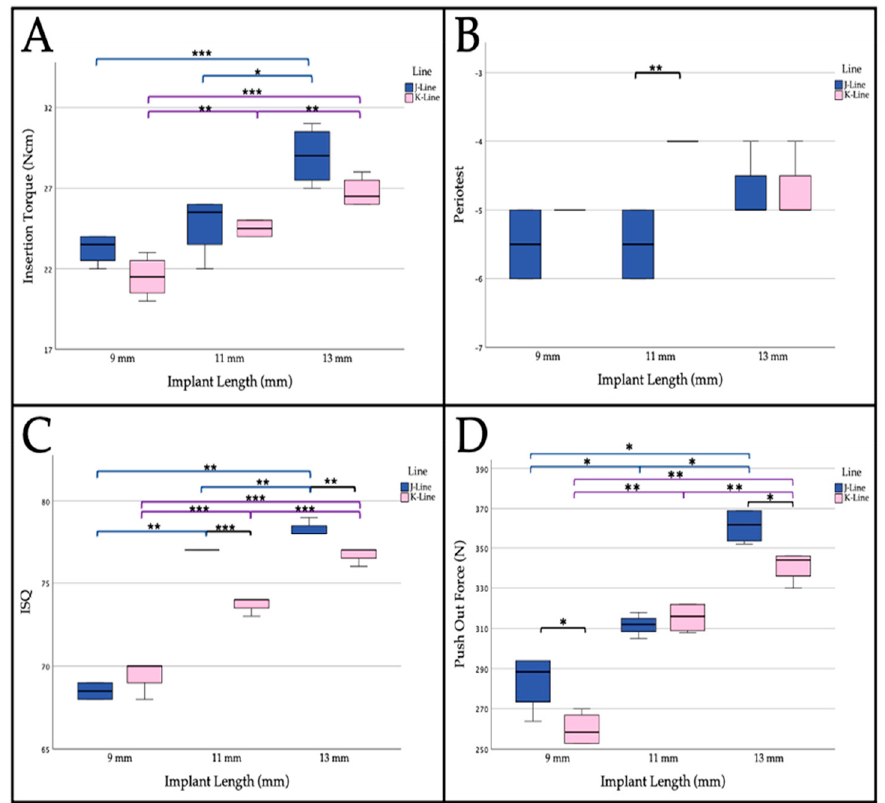
Figure 4. Boxplots illustrating ( A ) insertion torque, ( B ) Periotest ® measurement, ( C ) resonance frequency analysis and ( D ) push-out forces of the J- and K-lines at different implant lengths in “hard” bone. Within-group significance in assigned colors (J-line blue, K-line pink) and between-group significance is assigned in black. Shown are means ± SD, * p < 0.05, ** p > 0.01, *** p < 0.001 .